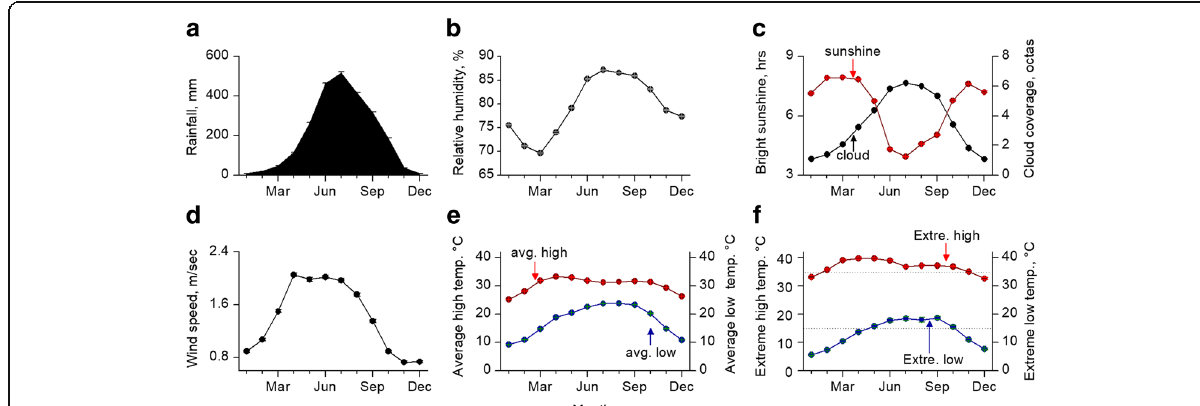
Fig. 11 Climatic features of Bangladesh. a Rainfall, b Relative humidity, c Bright sunshine hours and cloud coverage, d Wind speed, e Average high and low temperature, f Extreme high and low temperature (dotted lines represent the thresholds of rice cultivation). Climatic data